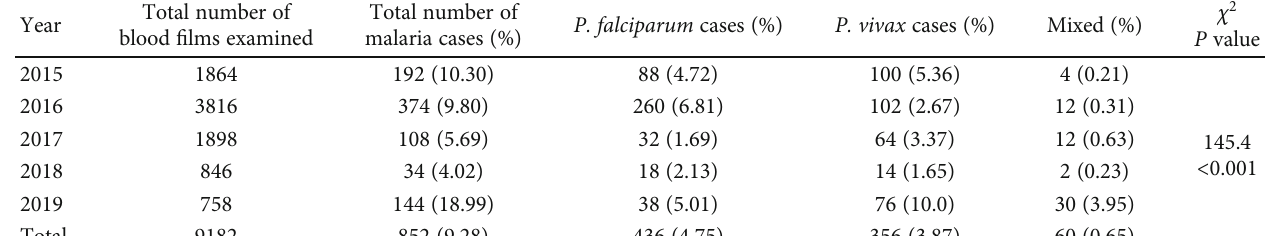
Table 1: Prevalence and annual trend of malaria at Bichena Primary Hospital from 2015 to 2019.